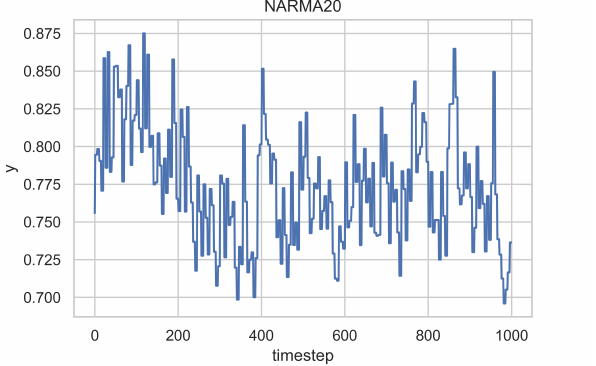
Figure 7. NARMA20 time-series as used in the